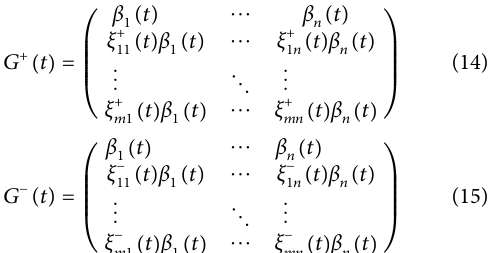
STEP 3: Establish an ideal gray correlation coef fi cient matrix. Referring to the grey correlation analysis principle, taking the positive ideal scheme Y + ( t ) and the negative ideal scheme Y − ( t ) as the reference sequence, then the gray correlation coef fi cient ξ + ij ( t ) for the number i evaluated object in the object set I , which ranges at the moment t